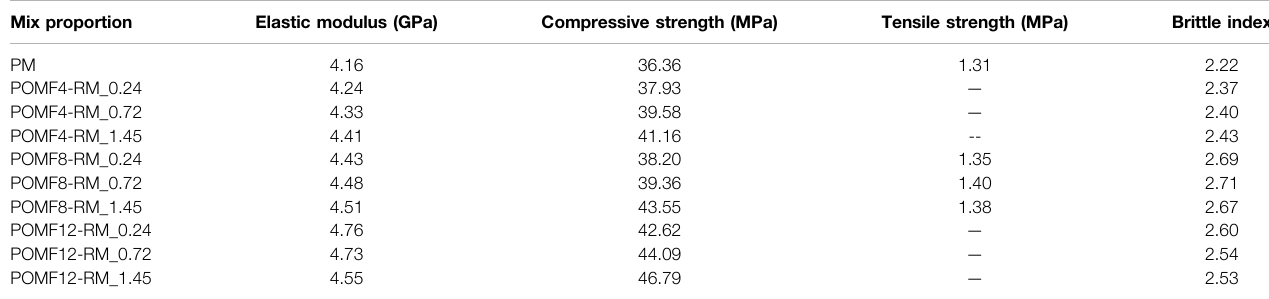
TABLE 2 | Test results of the PM and POMF-RM